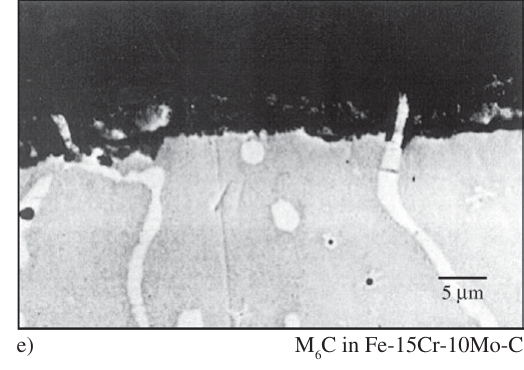
-O -HCl at 2 2 Cand M C are attacked 23 7 3 C, TiC and NbC are clearly 6